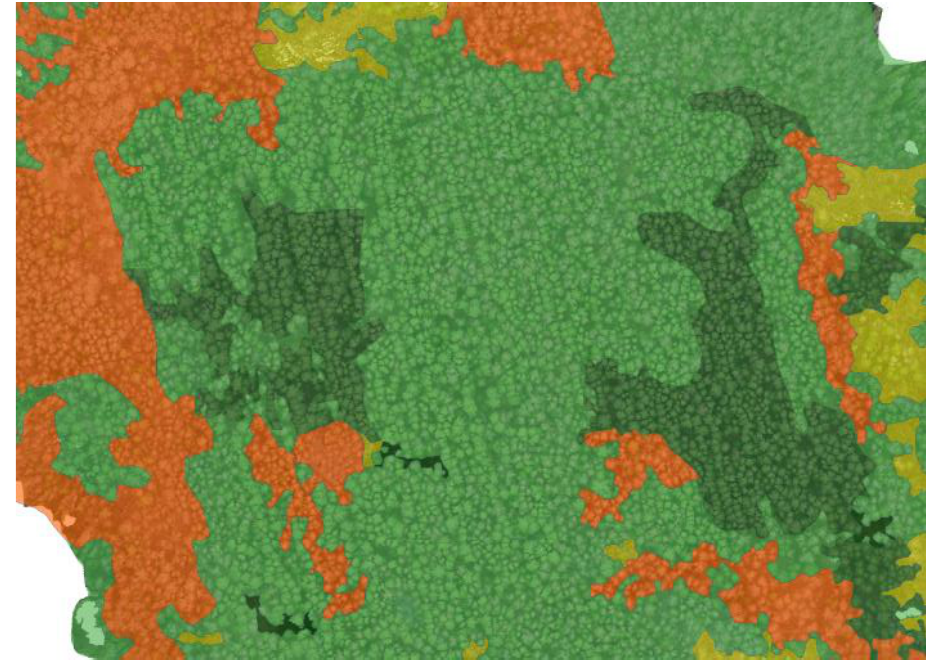
Figure 5. Assessment of fire danger in the experimental forest area using the proposed model .